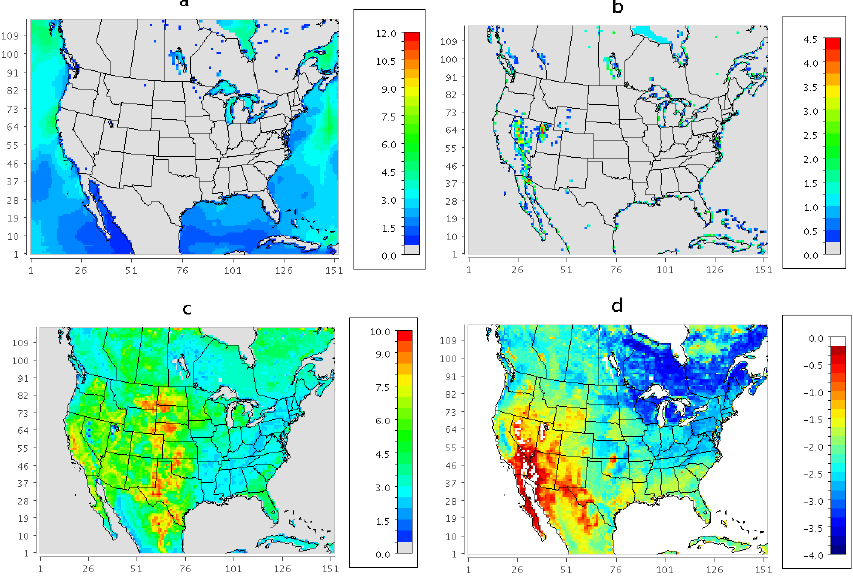
Figure 2. Monthly mean of the simulated Hg 0 flux (ngm − 2 h − 1 ) in the summer month: (a) flux from water bodies, (b) flux from bare lands, (c) flux from soil under the canopy and (d) flux from foliage.